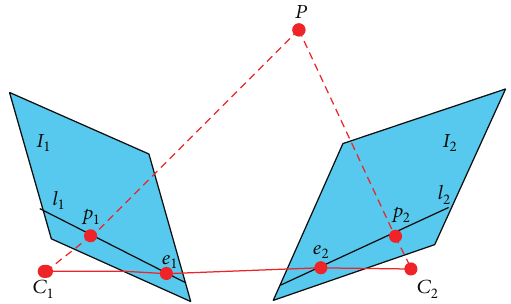
Figure 1: The schematic diagram of epipolar